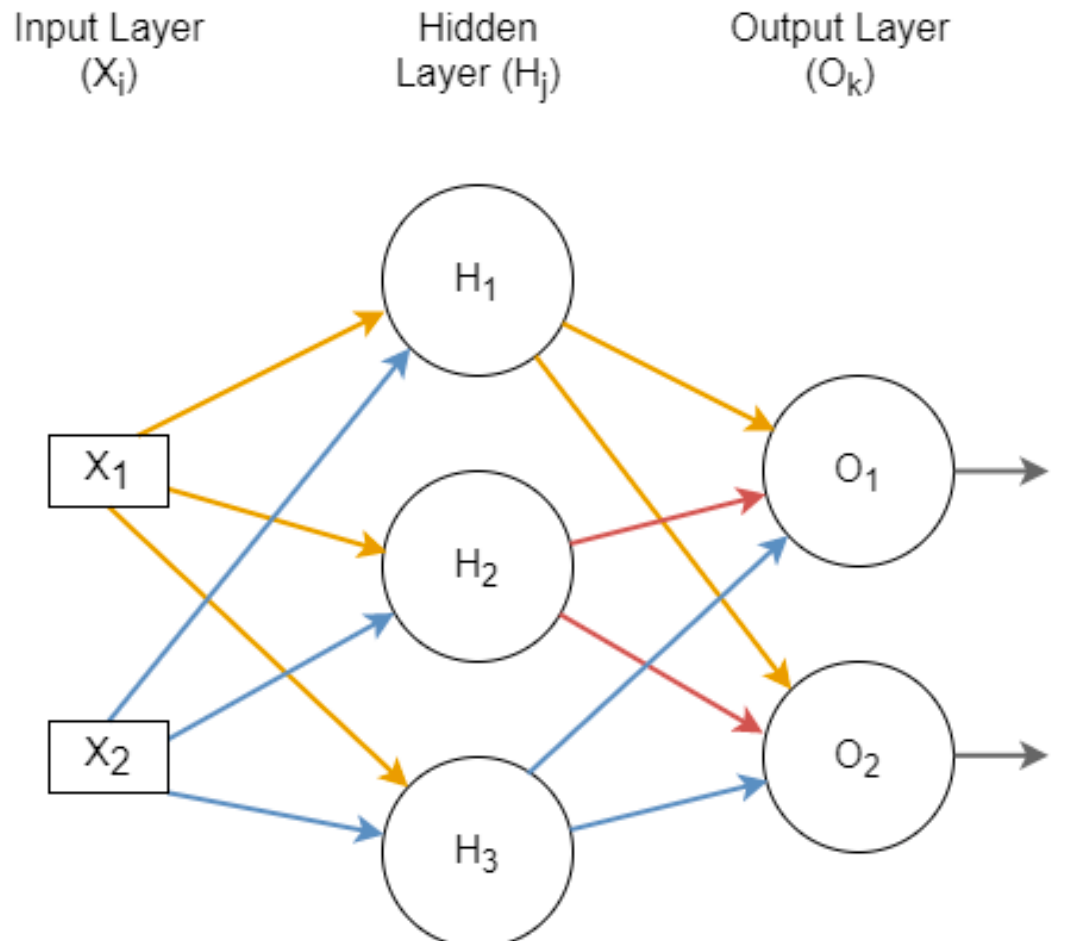
Figure 7. Multi-layer perceptron and its operations.